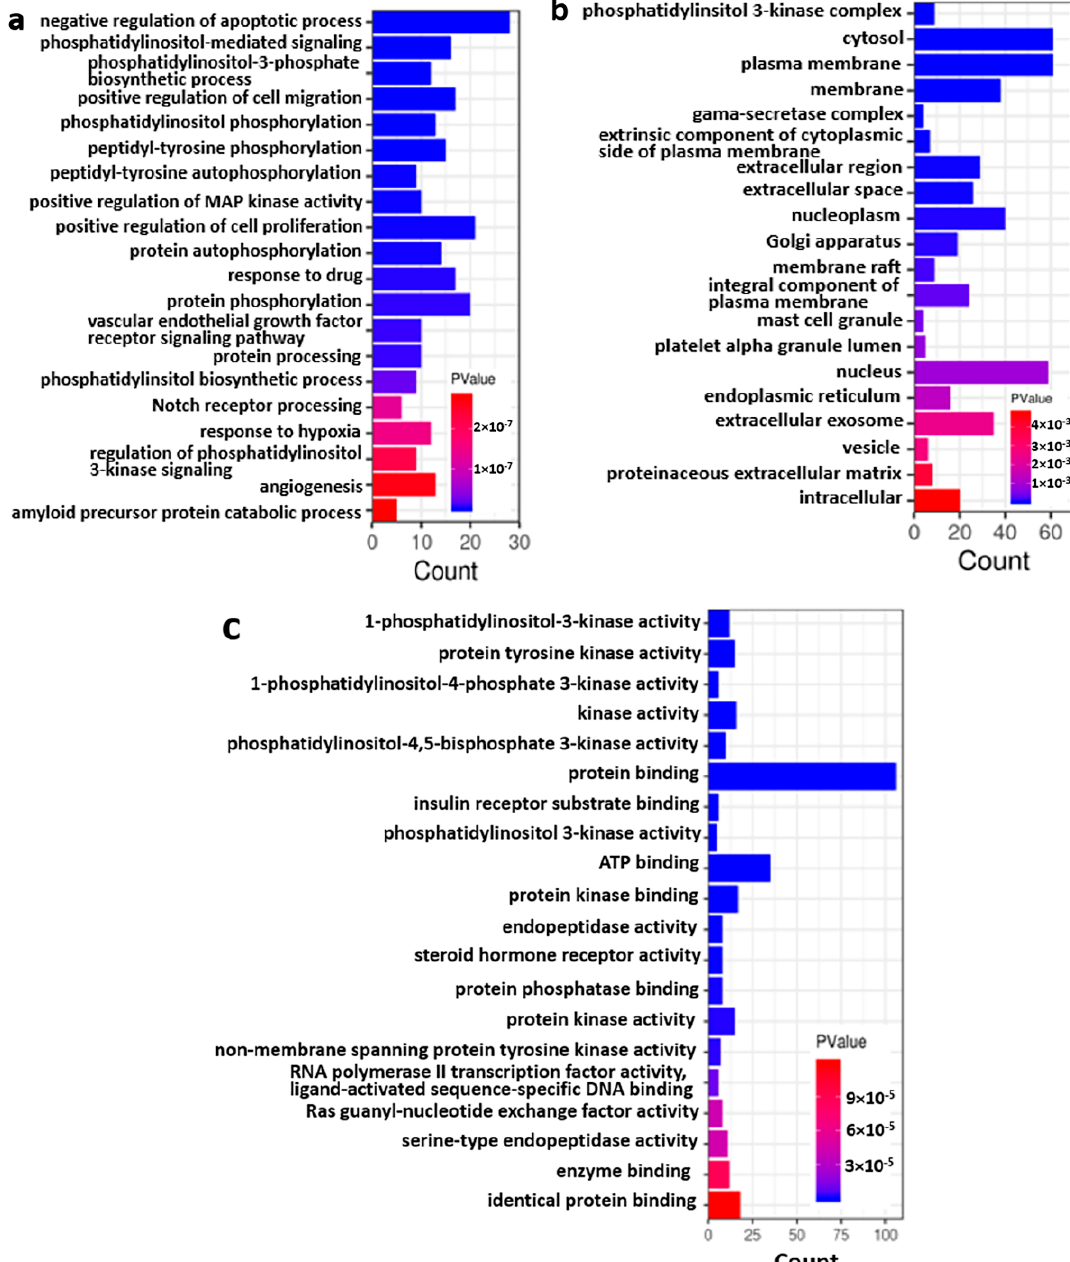
Figure 6. GO term enrichment for co-targets of GCK–osteoporosis (( a ): enrichment of biological process; ( b ): enrichment of the cellular component; ( c ): enrichment of the molecular function).